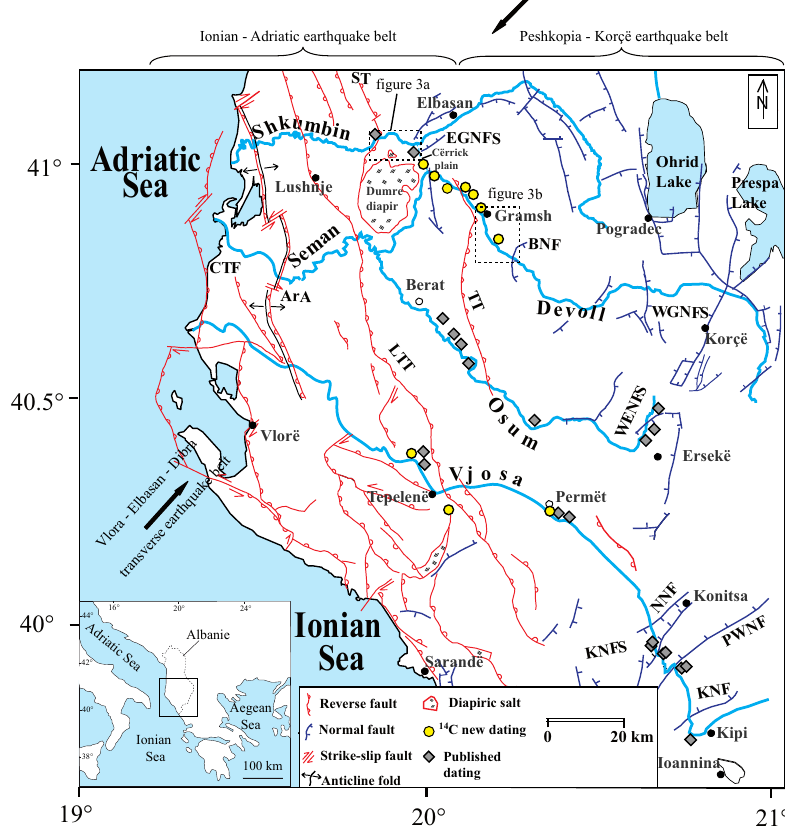
Figure 1. Neo-tectonic map of the Albania and northwestern Greece (modified from Aliaj et al. [1996, 2000] and Carcaillet et al. [2009]). Dark grey diamond indicate published data [Lewin et al. 1991, Hamlin et al. 2000, Woodward et al. 2001, Koçi 2007, Carcaillet et al. 2009] and yel- low circles indicate data computed in the present study. Fault types are described in the picture caption. The location of Figure 3a,b is shown in the map. (CTF) Coastal Thrust Fault; (ArA) Ardenica Anticline; (LTT) Lushnje - Tepelenë Thrust; (ST) Shkumbin Trust; (TT) Tomorrica Thrust; (BNF) Bulcar Normal Fault; (EG) Elbasan Graben Normal Fault System; (NNF) Nerotrivi Normal Fault; (KNFS) Konitsa Normal Fault System; (PWNF) Papingo West Normal Fault; (KNF) Kipi Normal Fault; (WGNFS) West Graben Normal Fault System; (WENFS) West Ersekë Normal Fault System. These abbreviations are kept unchaged for all figures and